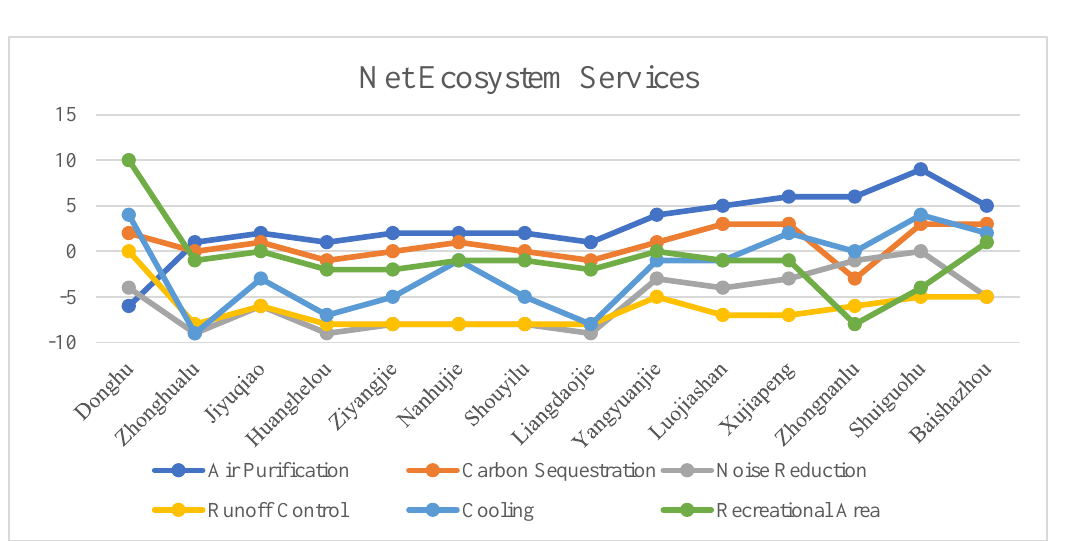
Figure 5. Net ecosystem services results.